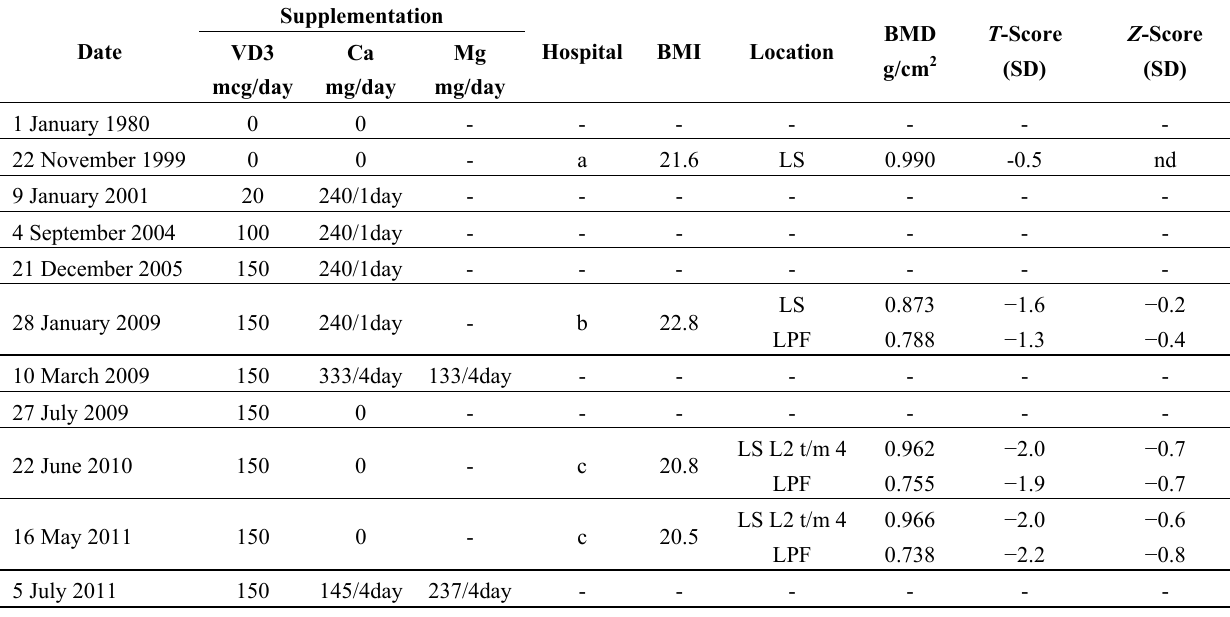
Table 2. Bone Mineral Index and Bone Mineral Density for Lumbar Spine and Left Proximal